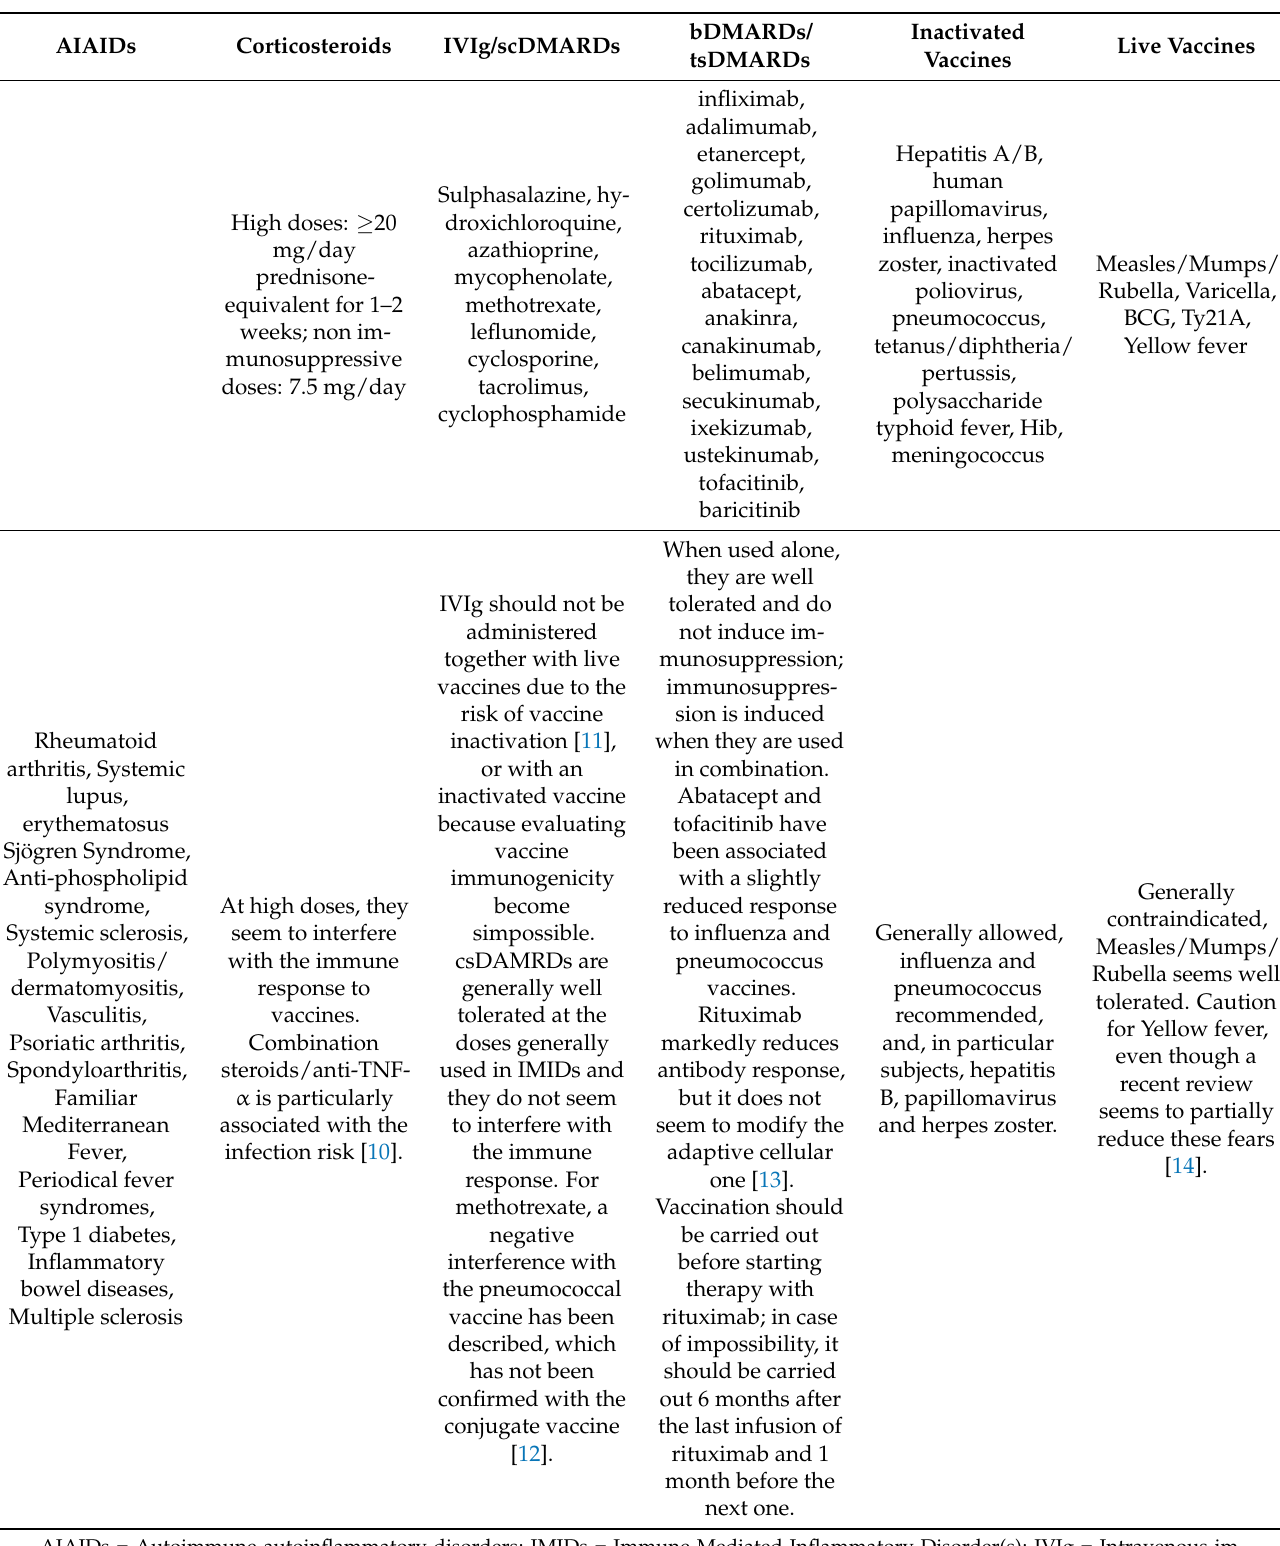
Table 1. Inactivated and live traditional vaccines (not anti-COVID-19) in patients with AIAIDs and influence of the relative